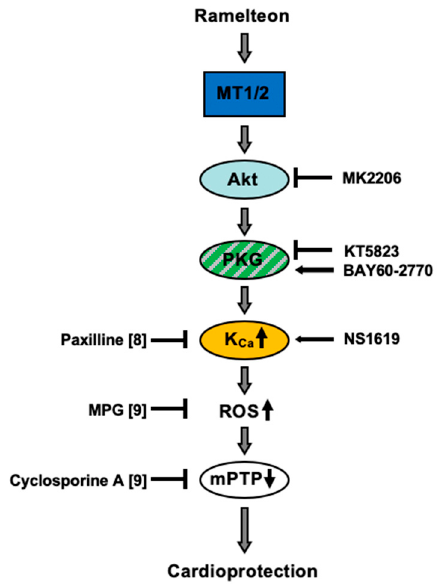
Figure 2. Possible signaling pathway of Ramelteon-induced cardioprotection against myocardial ischemia–reperfusion injury in rats. K Ca -channel = Ca 2+ -sensitive potassium (K Ca ) channel; KT5823 = PKG inhibitor; BAY60-2770 = sGC activator; MK2206 = Akt inhibitor; NS1619 = K Ca -channel activator;